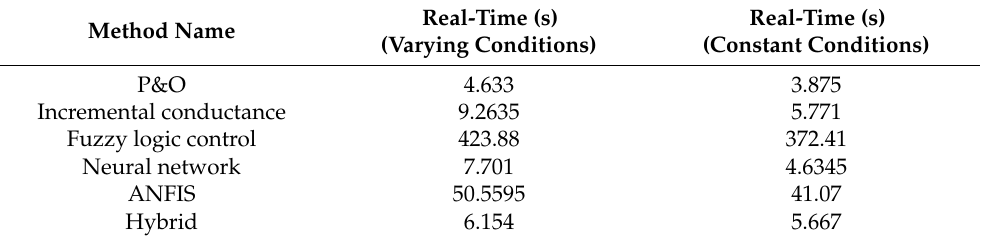
Table 7. Computational burden of MPPT